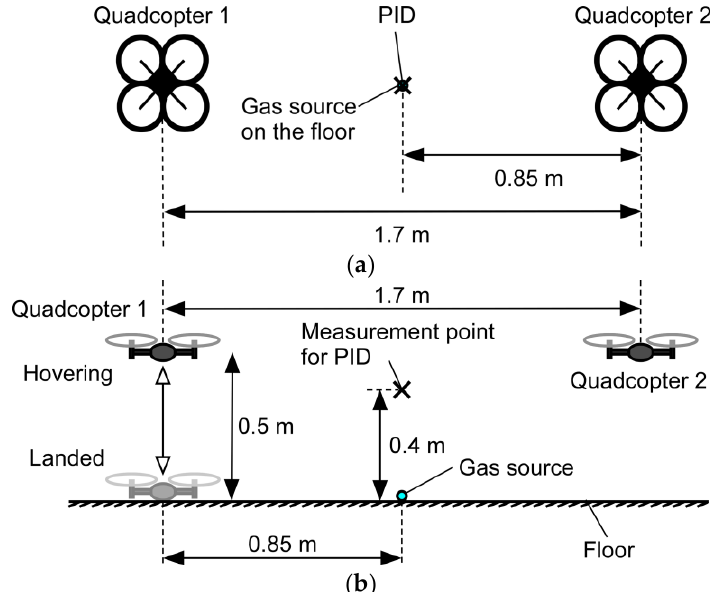
Figure 5. Experimental setup for detecting gas at an elevated height. ( a ) Top view; ( b ) side view. The photo-ionization gas detector (PID) reading measured when quadcopter 1 was hovering was compared to that measured when landed.